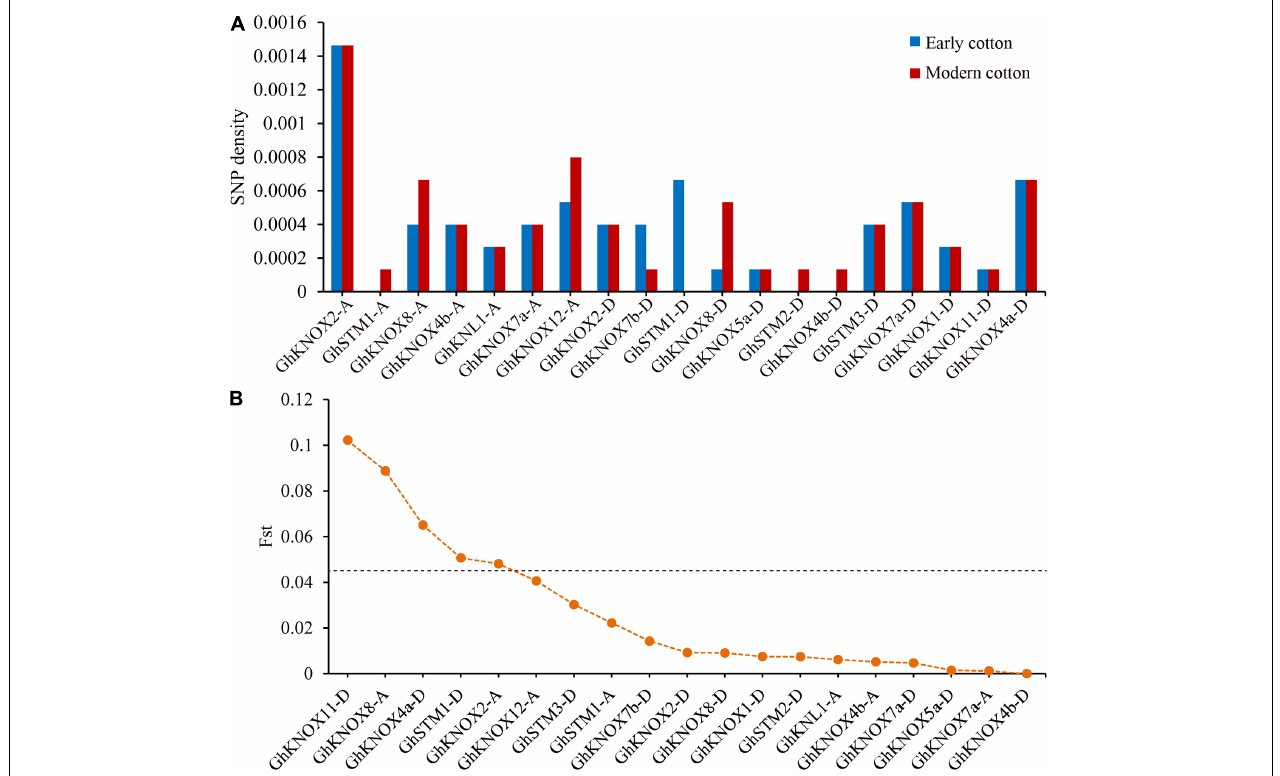
FIGURE 9 | Genetic variation in G . hirsutum KNOX genes. (A) Density of SNPs in 19 GhKNOX genes. (B) The F st values of the SNP loci in 19 GhKNOX genes. A F st value for a SNP locus higher than 0.45 was considered to indicate putative sites under selection during